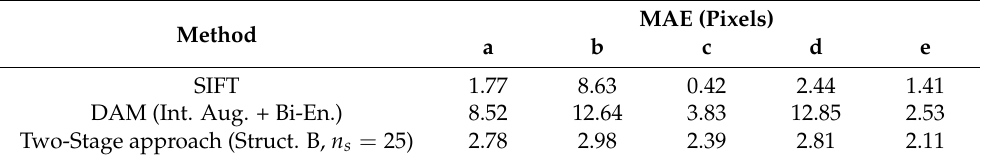
Figure 18. The results of registration on images with slight changes. ( a )~( e ) are different image pairs from the testing dataset. Rows are the source images, the target images and warped results by our method from top to bottom. “o” and “x” denote the keypoints in the source images and target images, respectively. Table 10. Comparison of registration results on the images displayed in Figure 18.